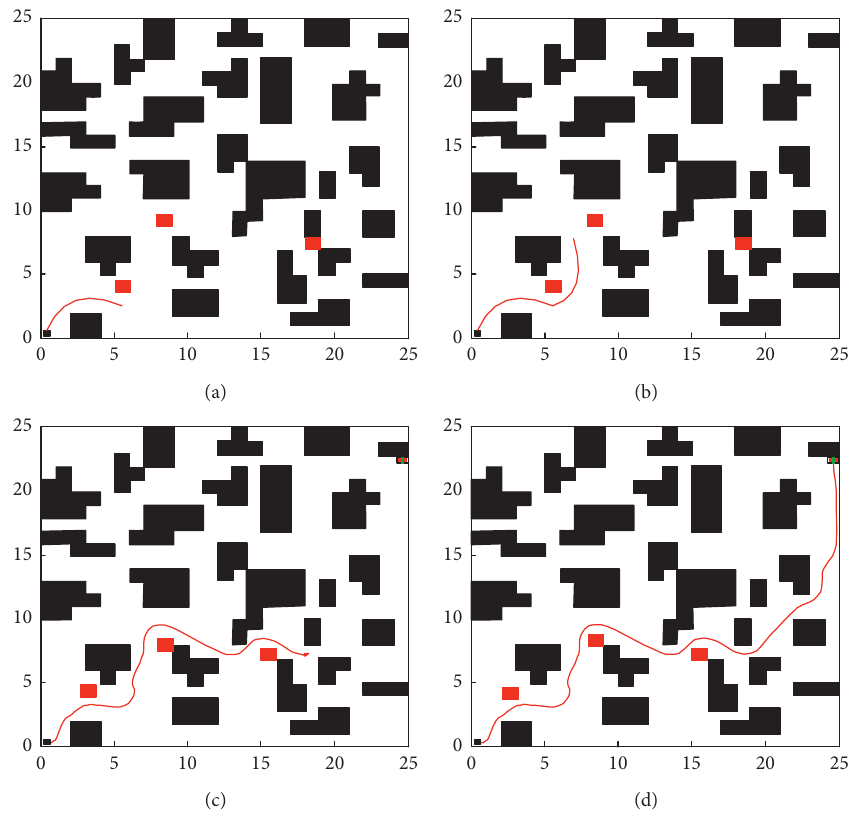
Figure 8: Path planned by the hybrid method after dynamic obstacles added to the map. (a) Hybrid path planning a . (b) Hybrid path planning b . (c) Hybrid path planning c . (d) Hybrid path planning d